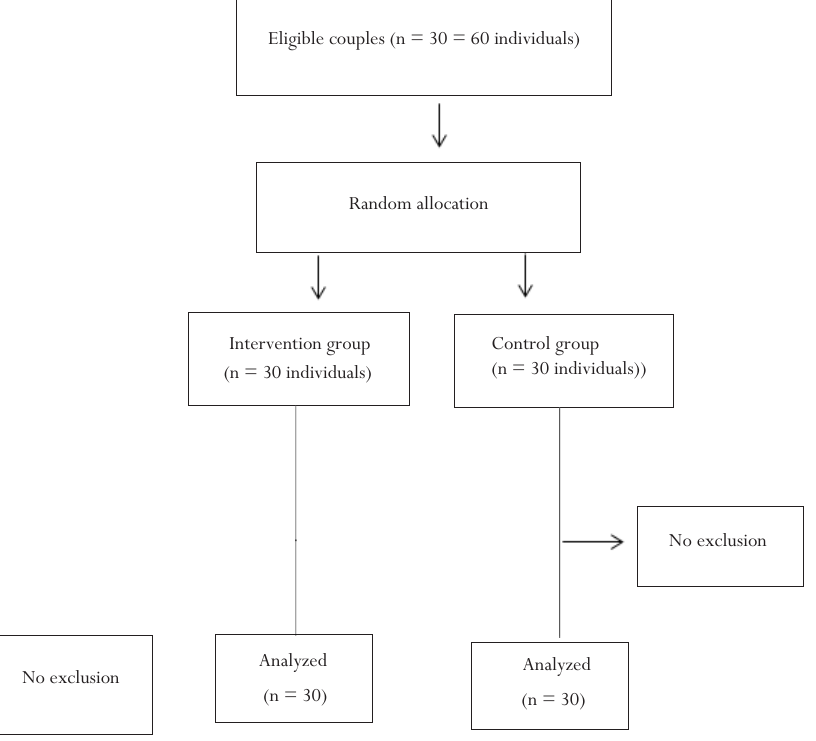
Figure 1. The flow diagram of the study.